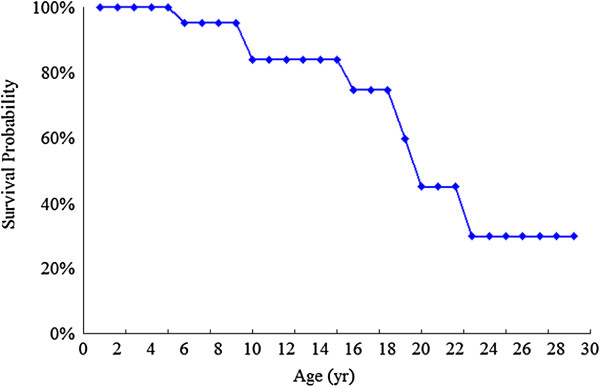
Kaplan-Meier Survival Curve for 24 Patients with MPS IVA in Taiwan.